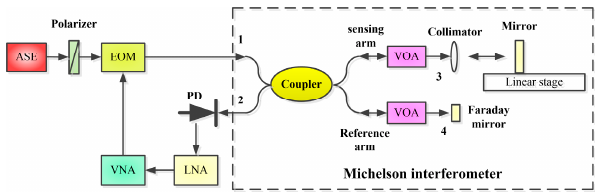
Figure 1. Schematic of the displacement sensor based on MWPI.